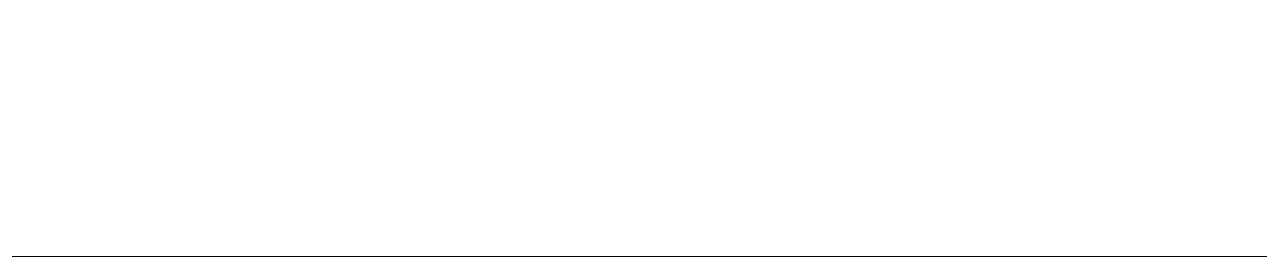
FIGUREA4 |Validation of the array profiling by examining specific miRNA clusters. All miRNAs from the miR-297-669 loci displayed similar expression dynamics demonstrating the validity of the array analysis. Similar expression dynamics were also observed for other miRNA clusters (Figure 2 and TableA2 in